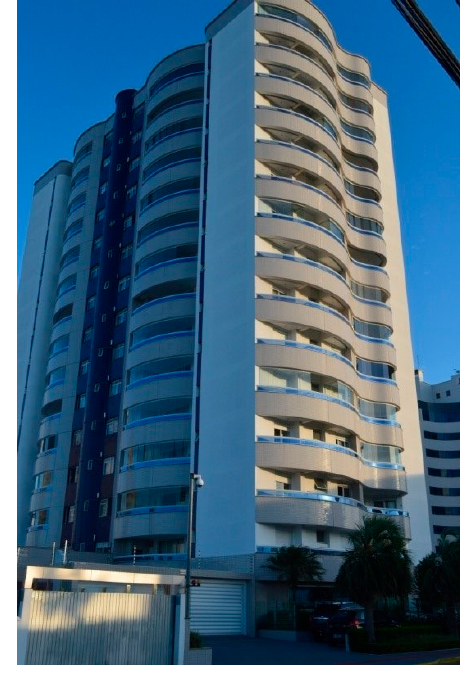
Figure 3. Building facade. Table 1. Areas of flat